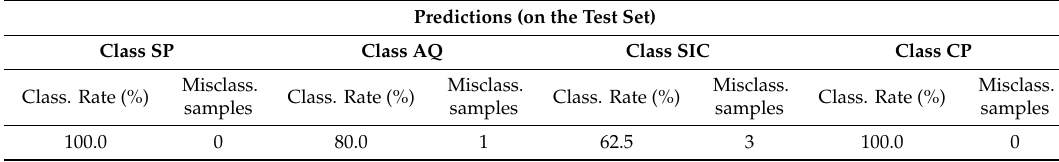
Table 3. SO-CovSel-LDA analysis: External Validation. Correct classification rates (%) and number of misclassified test